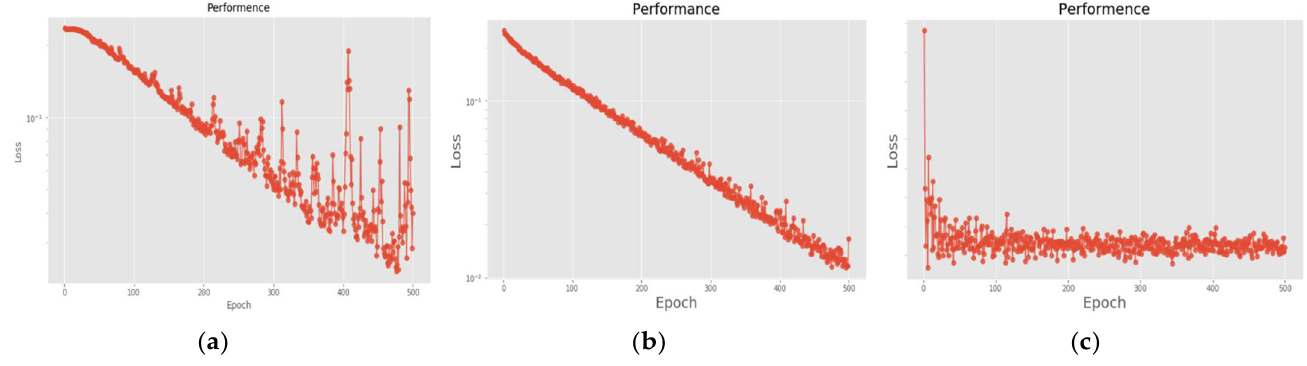
Figure 18. Loss function of LPC 30 feature dataset. ( a ) LPC + DNN. ( b ) LPC + CNN. ( c ) LPC + LSTM.